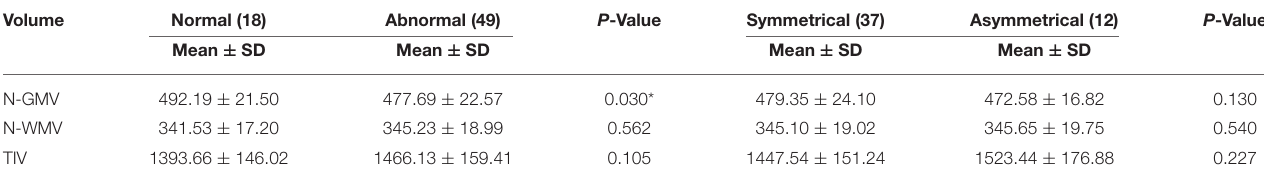
TABLE 4 | The relationship between EEG characteristics and brain